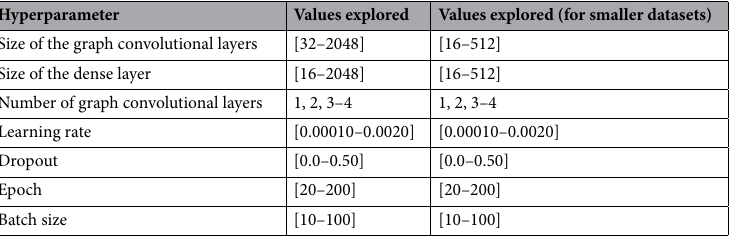
Table 1. Hyperparameters and values